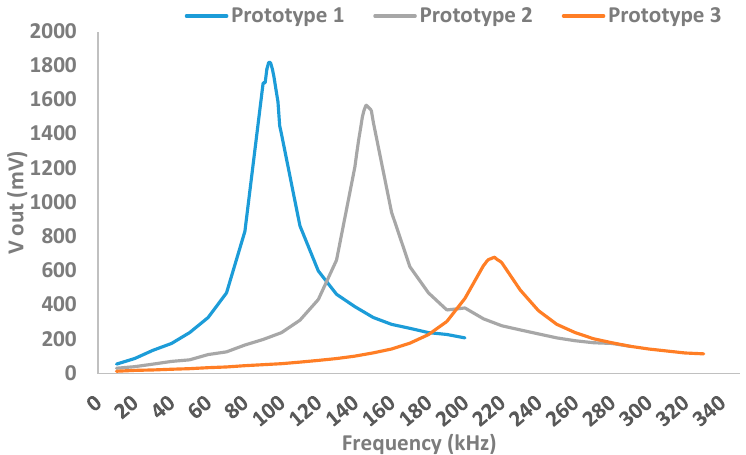
Figure 6. Resonance frequency obtained for each prototype.